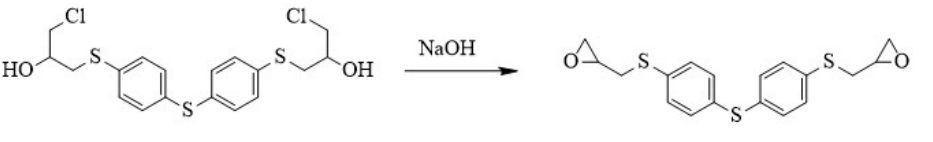
Figure 2. Synthesis of DGETDBT (step 2).